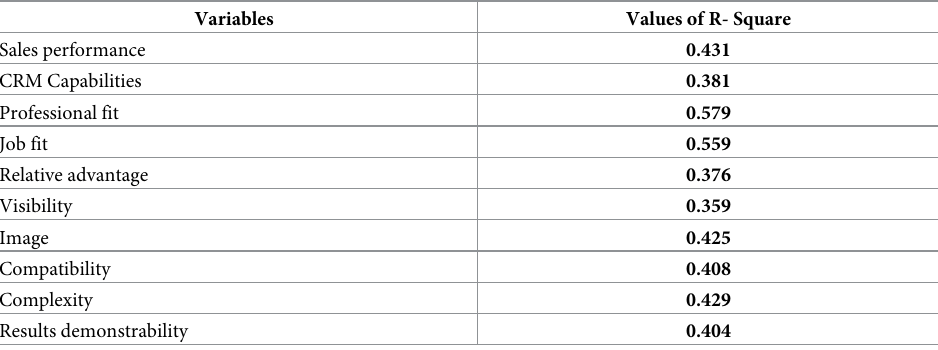
Table 6. Values of R-